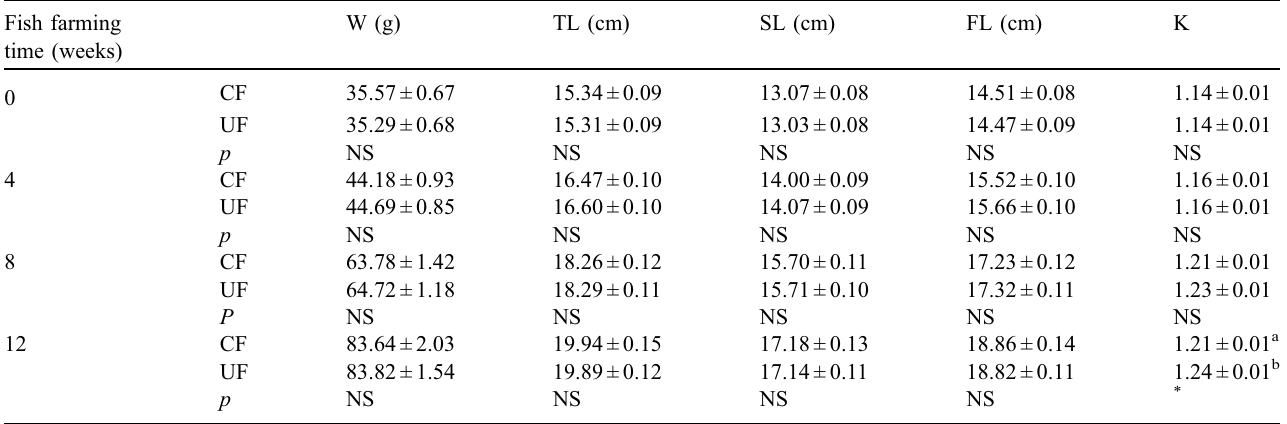
Mean values at the same column and week with different letter in superscript are signi fi cantly